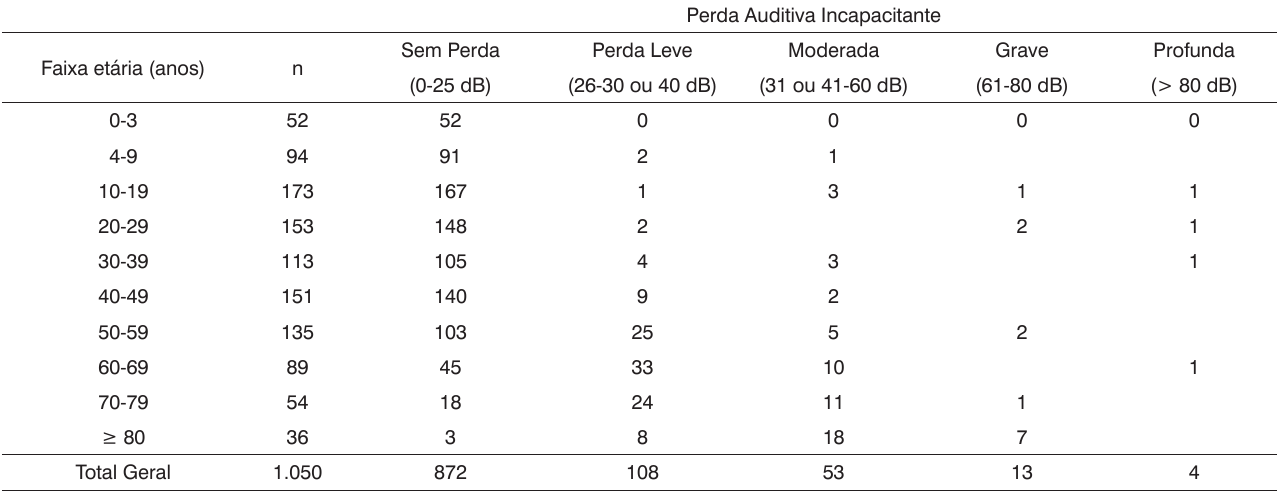
Tabela 2. Número de indivíduos (n) classificados em função do nível de audição da melhor orelha e por faixa etária, Juiz de Fora, MG, Brasil, 2011.